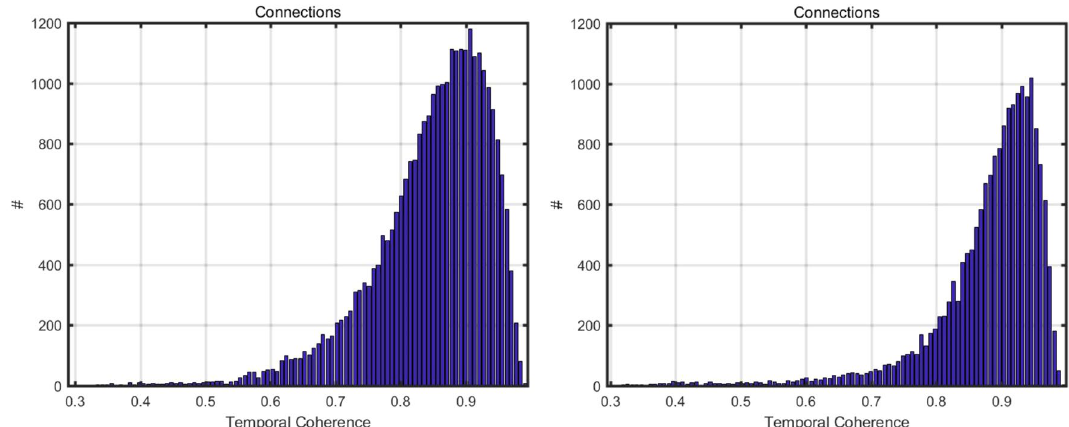
Figure 6. The graphs between the temporal coherence and connections for Ascending path on the left side and Descending path data on the right